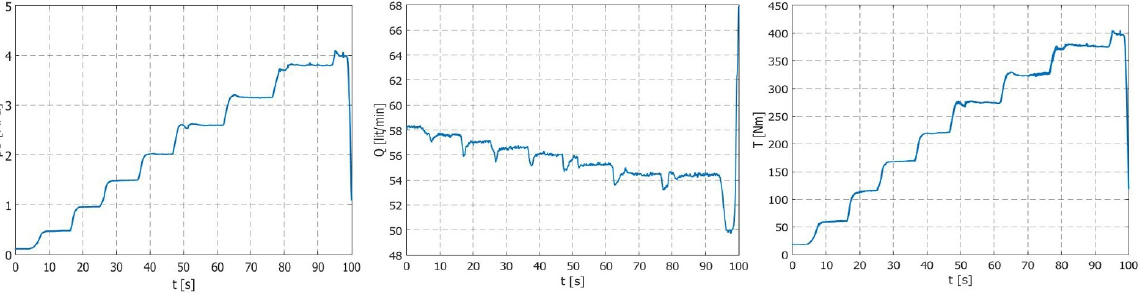
Figure 9. Diagram of dependence of the output pressure, working fluid’s flow rate, and torque of the pump shaft over time in the IR5 operating mode.